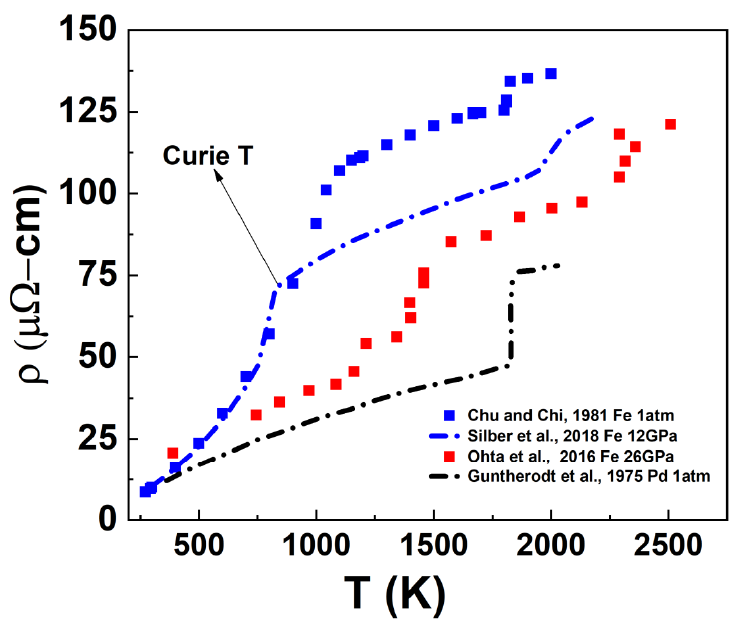
ff erent P compared with Pd at 1 atm.